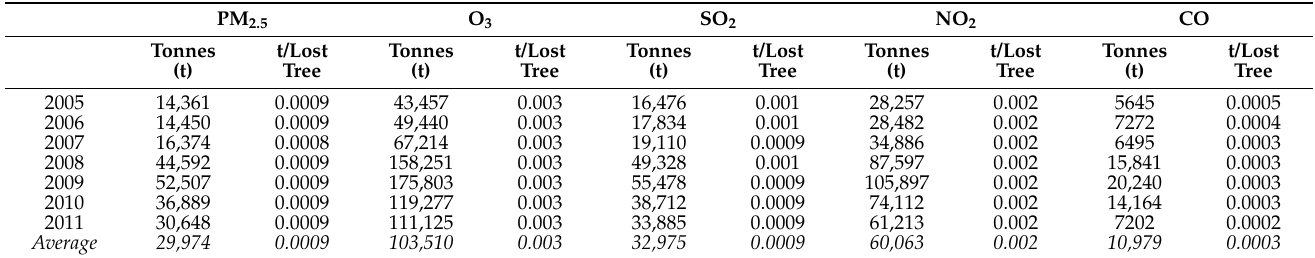
Table 2. MPB air pollution impacts by year for Western US, 2005–2011. PM 2.5 SO